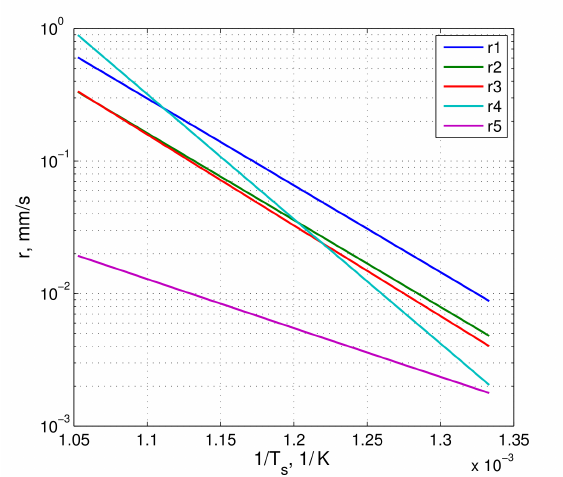
Figure 4. HDPE regression rate vs. temperature from various pyrolysis laws.